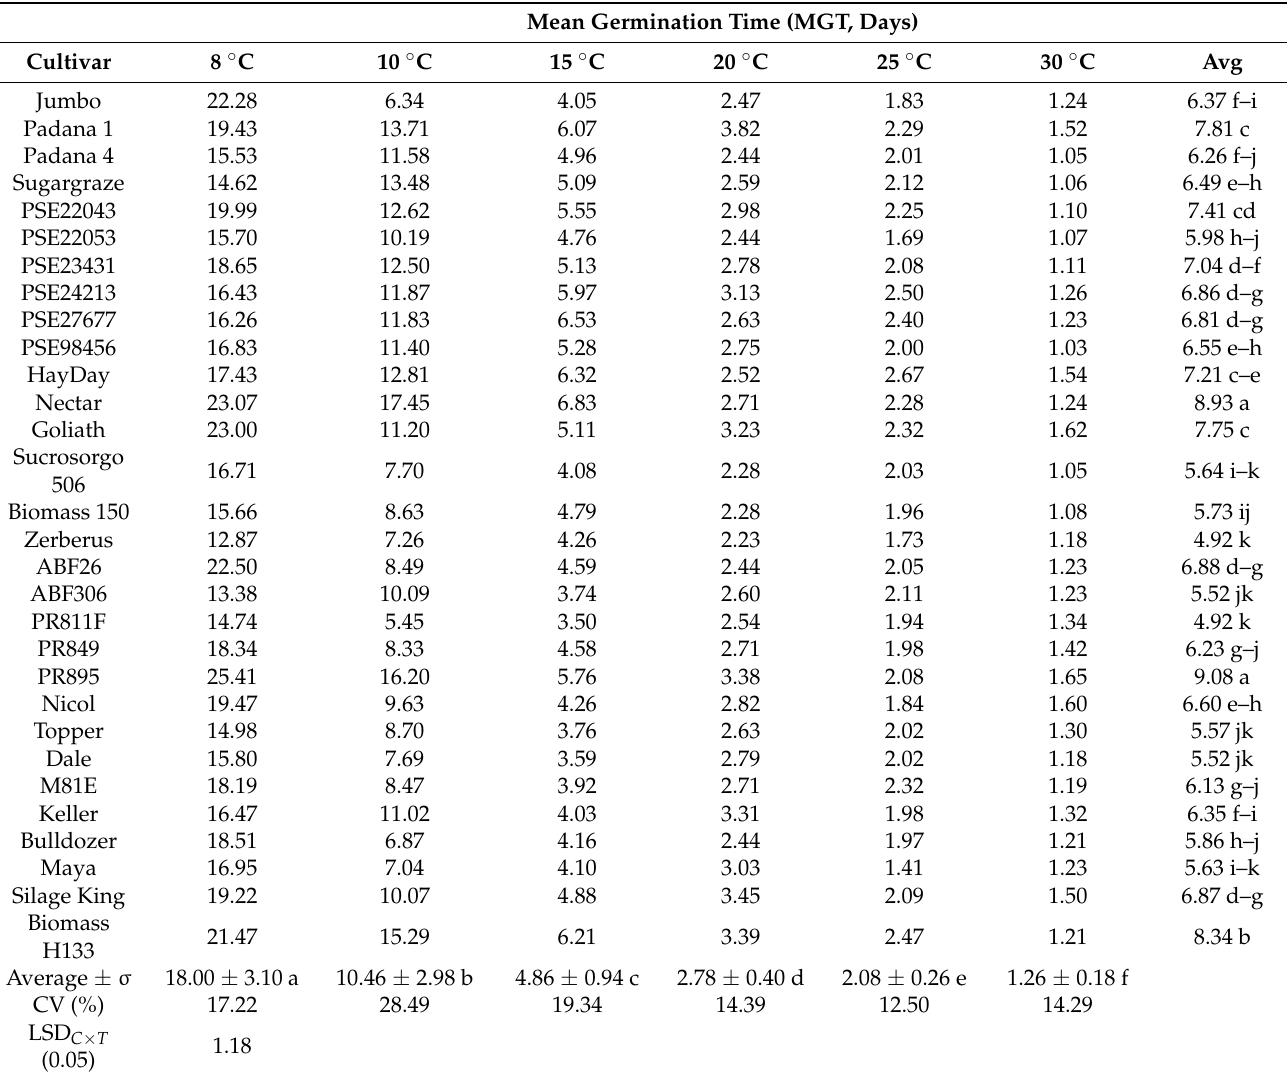
Table 4. Mean germination time in sorghums in response to temperature. Values for the main factors (temperature and cultivar) followed by the same letter do not statistically differ at p ≤ 0.05 by LSD test.